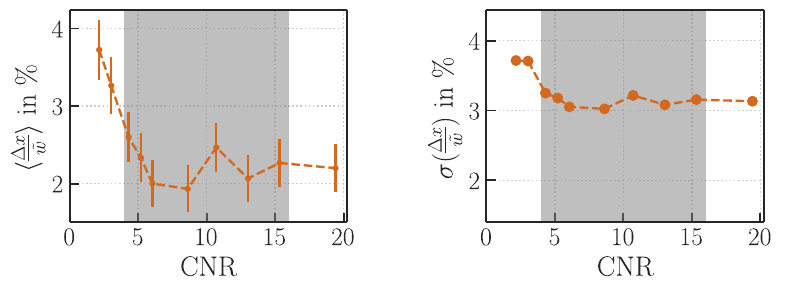
(cid:68) ∆ (cid:69) x normalized by the average wedge width (see ˜ w ∆ x in percent, which represents the random (cid:104) ˜ w (cid:105)